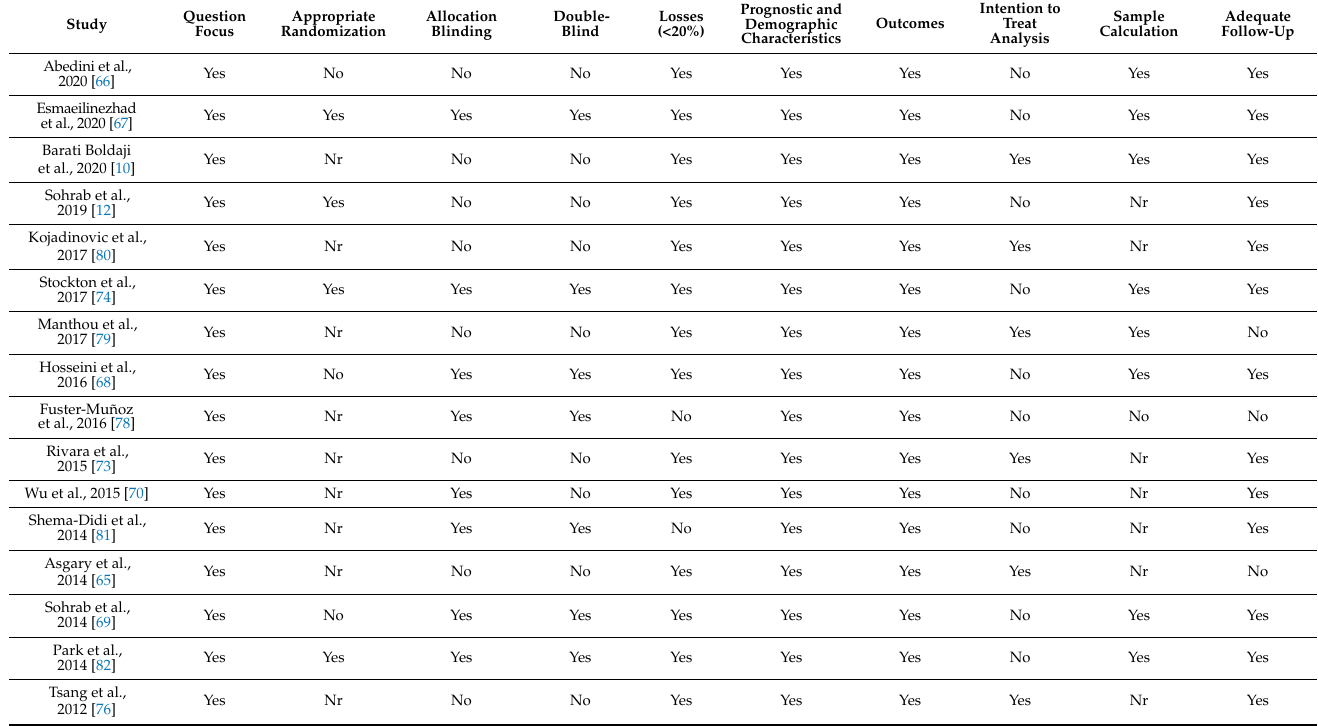
Table 3. Possible biases of the included randomized clinical trials